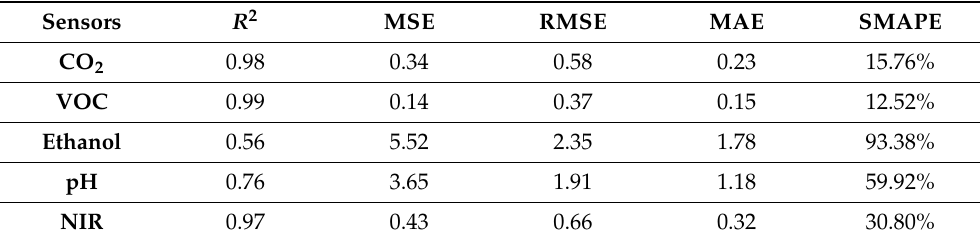
Table 5. Performance Metrics Random Forest Regressor.